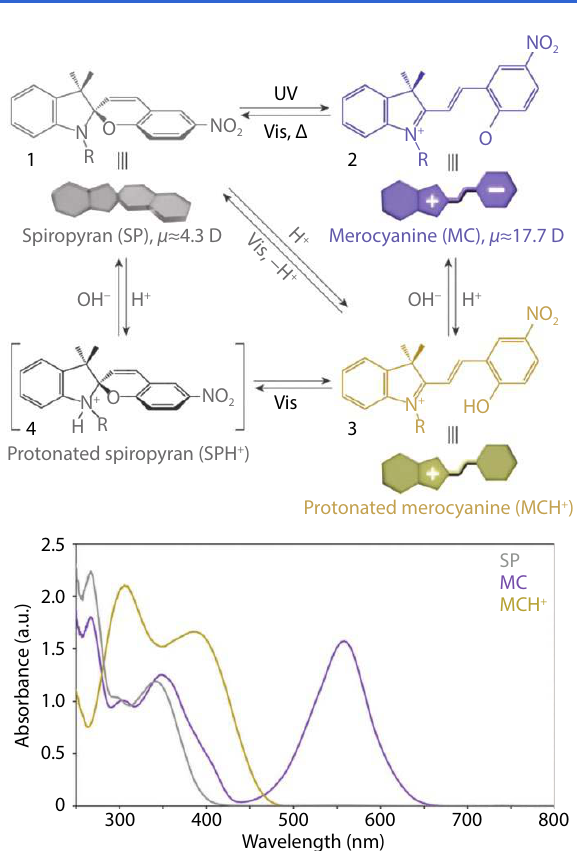
Fig. 8 Photochromism and acidochromism of spiropyran. ( a ) Reversible transformations between the four states: spiropyran (SP) 1, merocyanine (MC) 2, protonated merocyanine (MCH + ) 3, and protonated spiropyran (SPH + ) 4. ( b ) UV–Vis spectra of the parent spiropyran before (gray) and after (purple) UV irradiation, and after the addition of HCl (yellow). Reprinted with permis- sion from ref. [151], © 2014 The Royal Society of